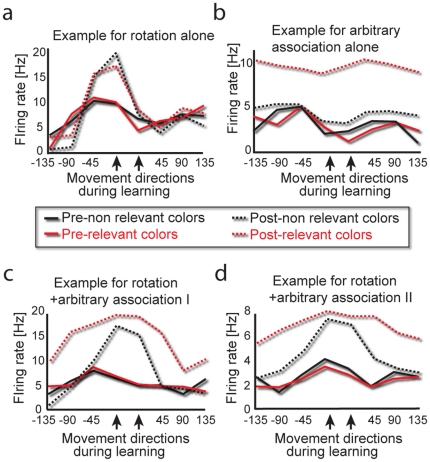
Examples of simultaneous representation in single neurons.Examples of single neuronal responses during the center-out task before and after learning of (a) rotation alone, (b) arbitrary association alone or (c–d) rotation followed by arbitrary association. Red indicates center-out responses to target colors used during the learning blocks, black indicates responses to target colors not used. Solid lines represent activity before learning; dashed lines represent activity after learning. Directions are aligned according to distance from the direction used during the learning blocks.